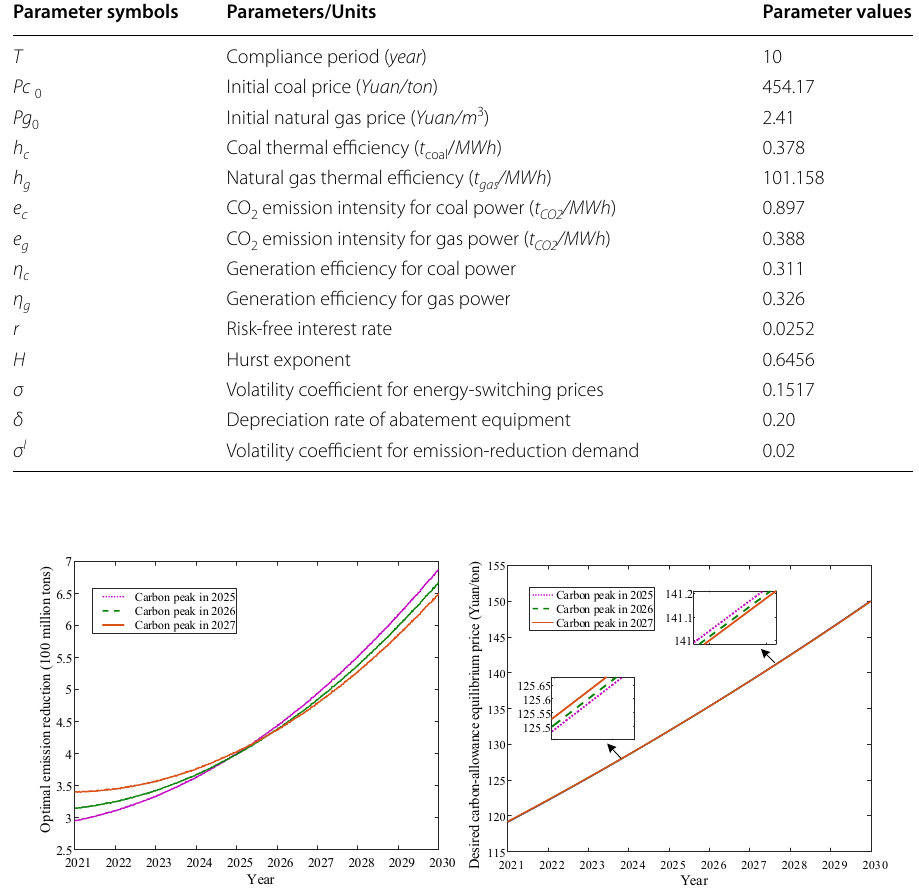
Fig. 7 Optimal emission reductions and desired carbon-allowance equilibrium prices for scenarios of different peak